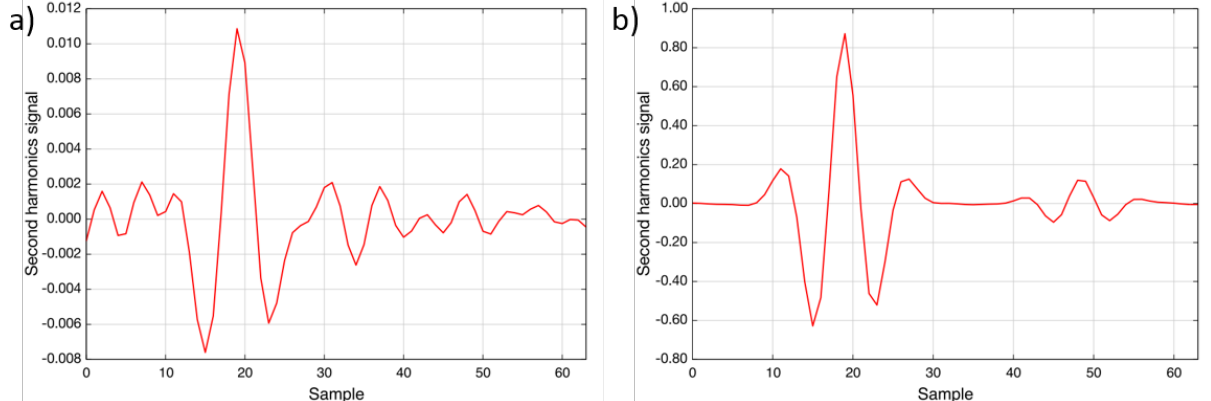
Figure 9. Two recorded spectra during the measurement campaign: ( a ) was recorded during the restart after power failure (1.5 mg/Nm 3 NO); ( b ) was measured during regular operation (114.8 mg/Nm 3 NO)